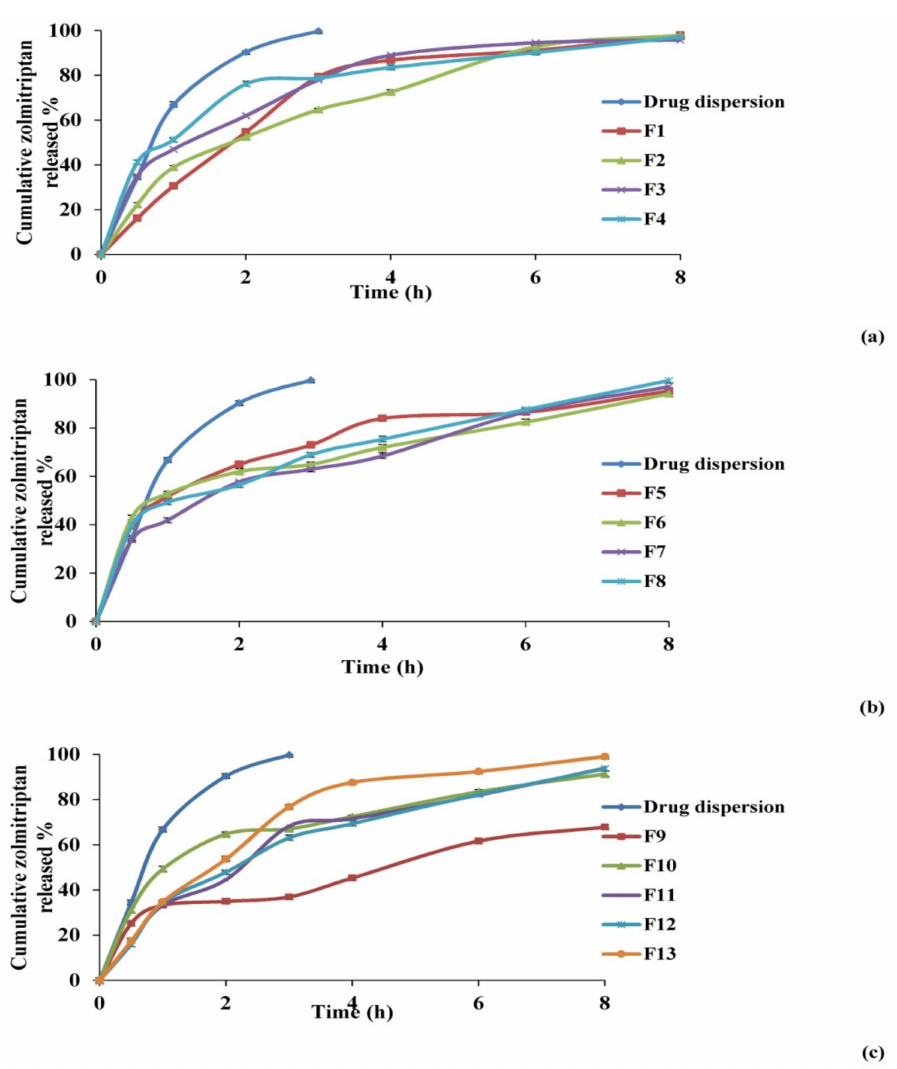
Figure 3. Release profiles of zolmitriptan from the prepared bilosomes compared to aqueous drug dispersion in phosphate buffer saline (pH 7.4); F1–F4 ( a ), F5–F8 ( b ) and F9–F13 ( c